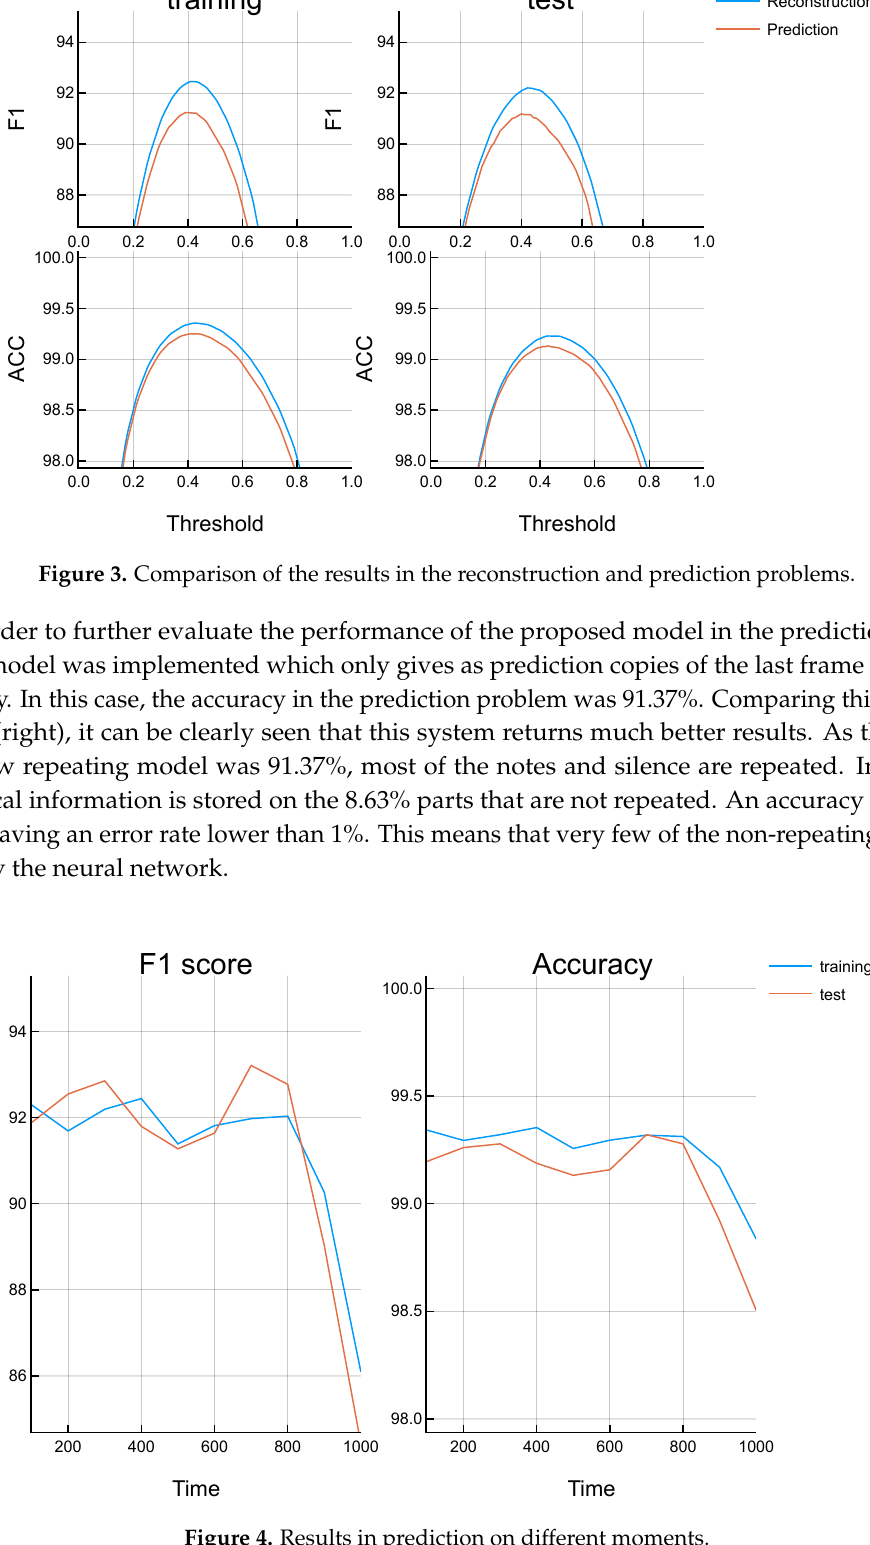
Figure 4. Results in prediction on different